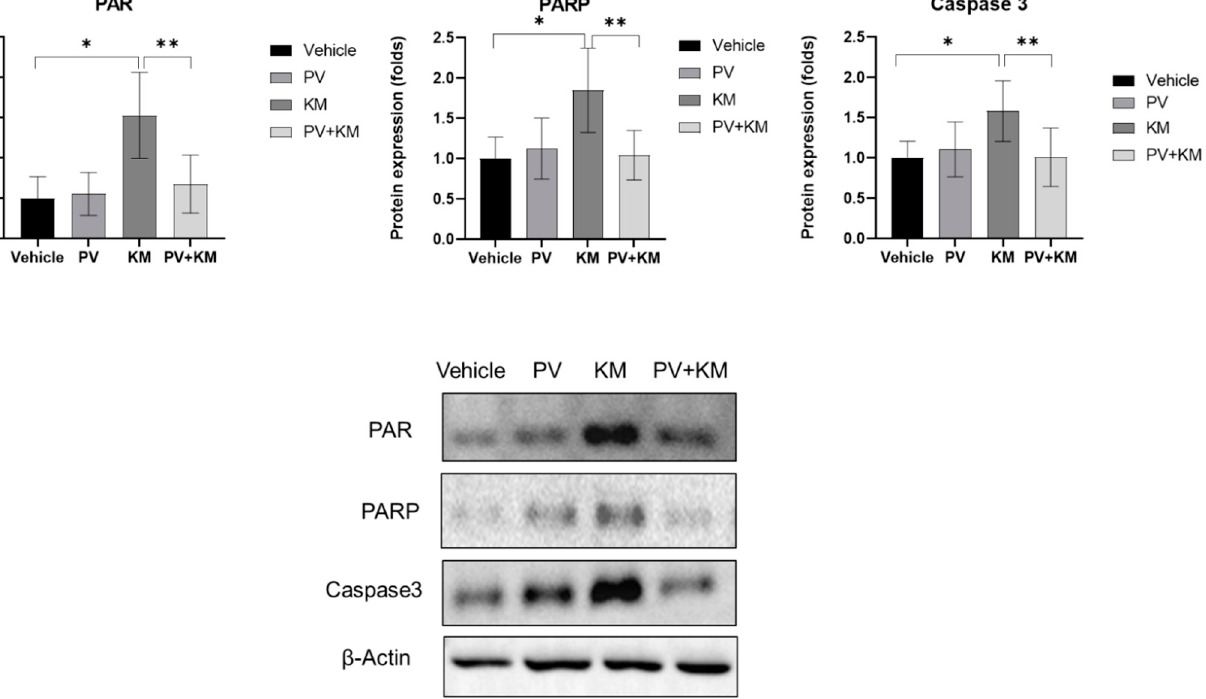
Figure 4. The Western blotting results of PARP, PAR, and caspase 3. The PV + KM group demonstrated lower levels of PARP, PAR, and caspase 3 than the KM group (* p < 0.05, Mann–Whitney U test between the control and KM groups; ** p < 0.005, Mann-Whitney U test between the KM and PV + KM groups).